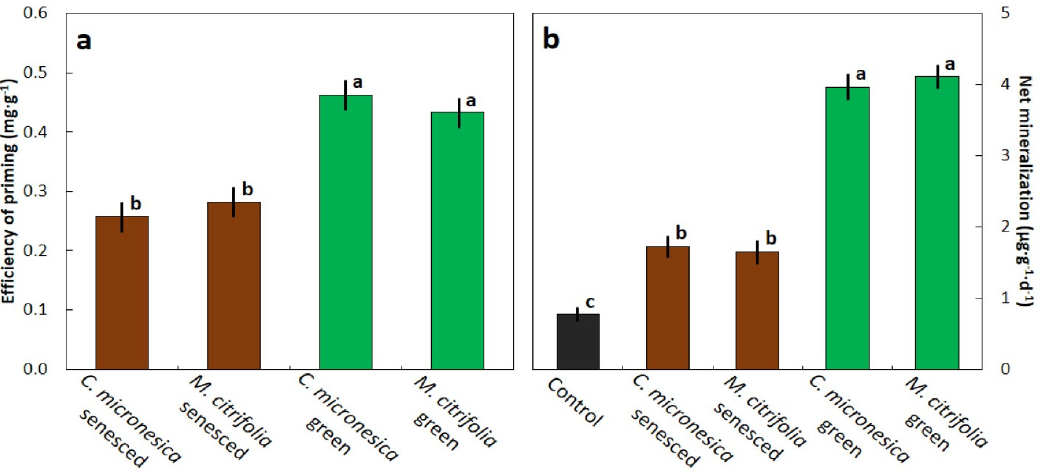
Figure 4. The influence of soil priming with Cycas micronesica or Morinda citrifolia leaf litter on changes in the nitrogen status during a 117-d incubation period. ( a ) efficiency of priming; ( b ) net mineralization. Bars with same letter are not statistically different according to Tukey’s HSD. Mean ± SE, n = 3.